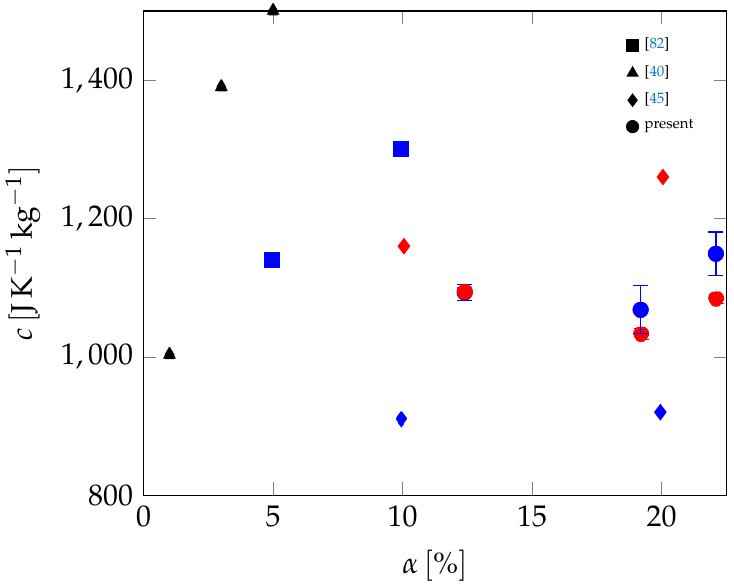
Figure 13. Comparisons of the present estimations for the specific heat capacities for the solid (blue) and liquid (red) state with similar studies (black data mean that only an unique value has been given, without specifying the physical state (solid or